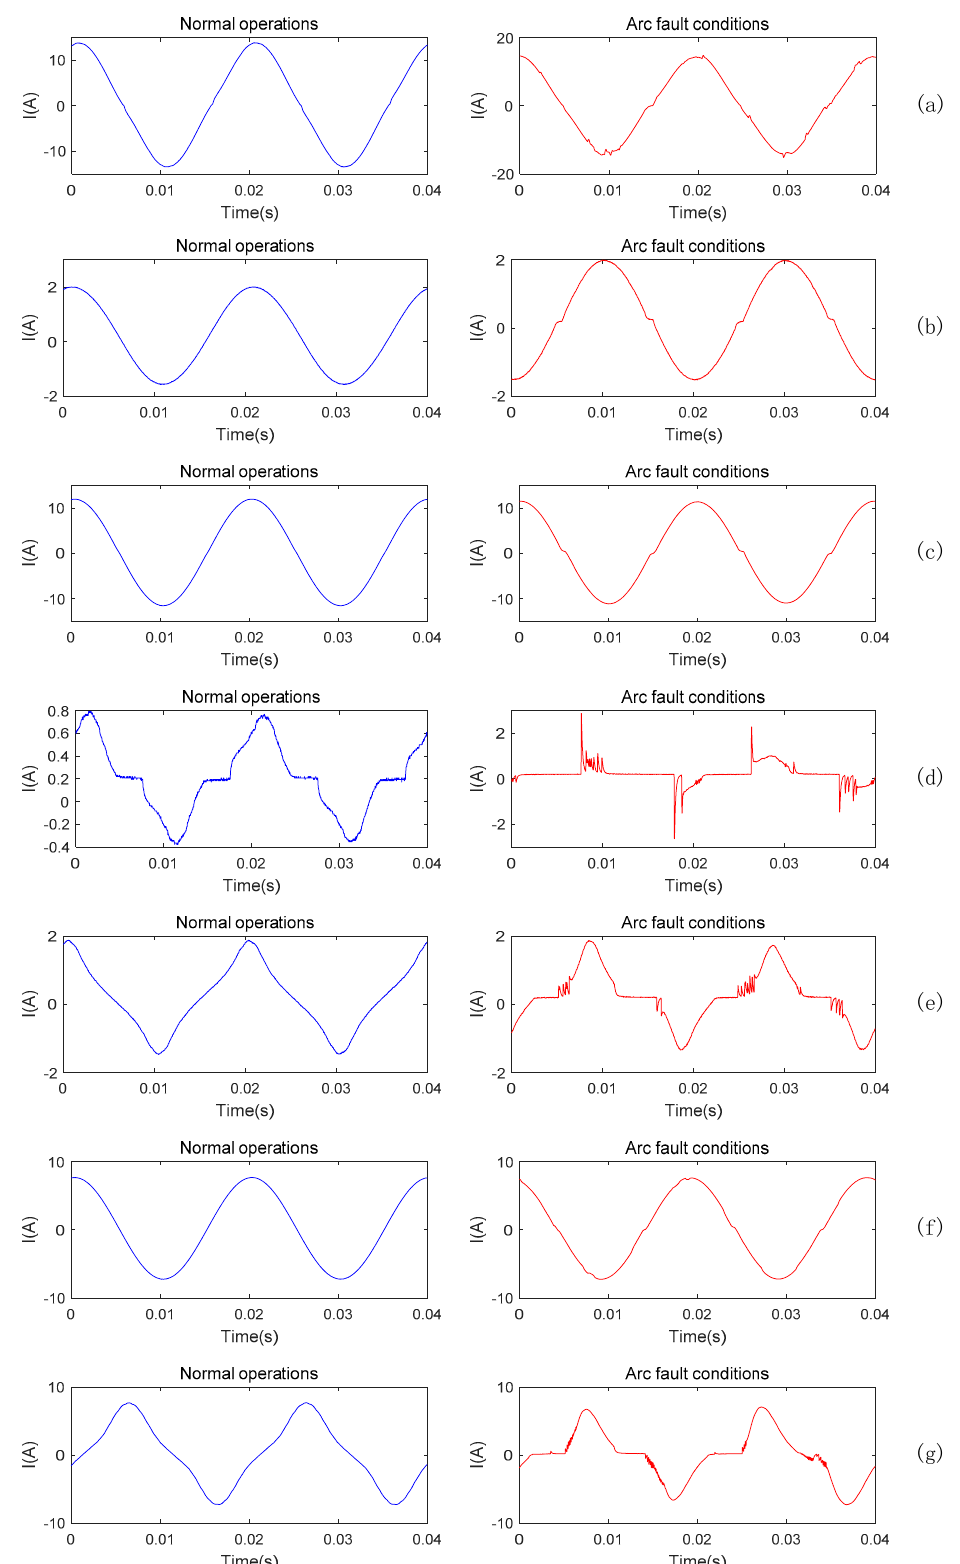
Figure 2. The waveform of different load types during normal operations and serial arc fault conditions. ( a ) Induction cooker. ( b ) Incandescent lamp. ( c ) Hairdryer. ( d ) Notebook computer. ( e ) Electric drill. ( f ) Electric oven. ( g ) Vacuum cleaner.